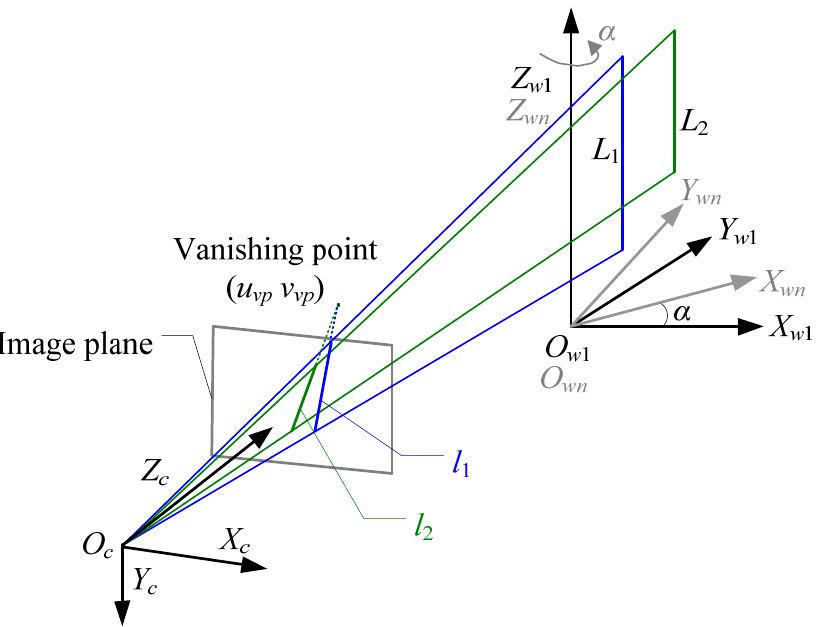
Figure 2. The projections of parallel lines of L 1 and L 2 , whose direction vector is a limitation of our proposed method.